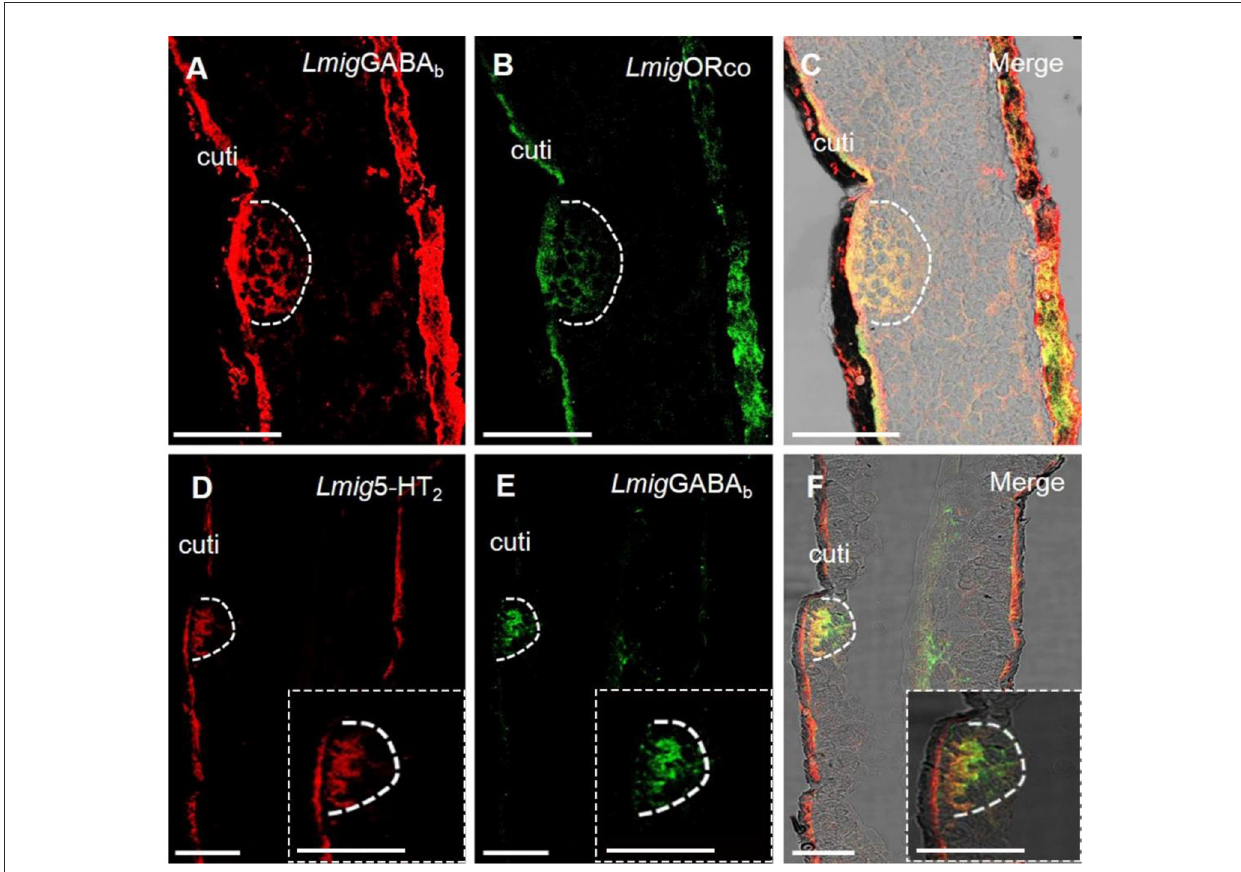
FIGURE4 Localization of Lmig GABA b by dual-color fluorescence in situ hybridization experiments in locust antennae. (A) Antennal cryosection stained by an antisense probe against Lmig GABA b RNA with DIG, red. (B) Antennal cryosection stained by an antisense probe against Lmig Orco RNA with BIO, green. (C) A and B merged with the brightfield image. (D) Antennal cryosection stained by an antisense probe against 5-HT 2 RNA with DIG, red. (E) Antennal cryosection stained by an antisense probe against Lmig GABA b RNA with BIO, green. (F) D and E merged with the brightfield image. Cuti, cuticle. Scale bars: 100 µ m. The dashed box in the lower right corner of (D–F) shows the enlarged staining